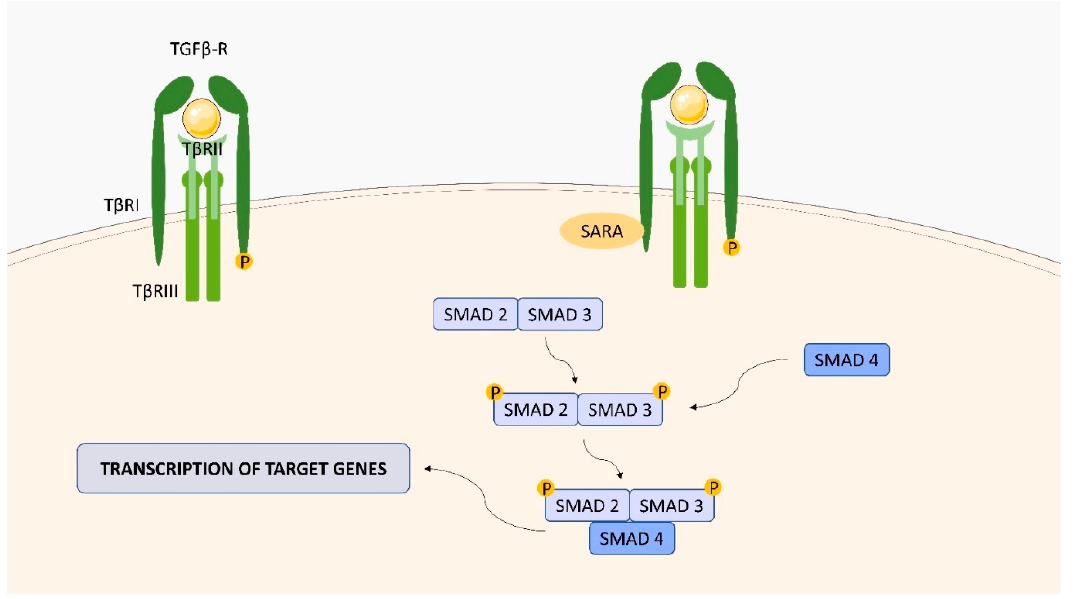
Figure 11. TGFBR structure and signaling. TGFBR consists of three subunits (TBRI, BRII, and BRIII). SMAD2 and SMAD3 are recruited to the type I receptor by the SMAD anchor for receptor activation (SARA).